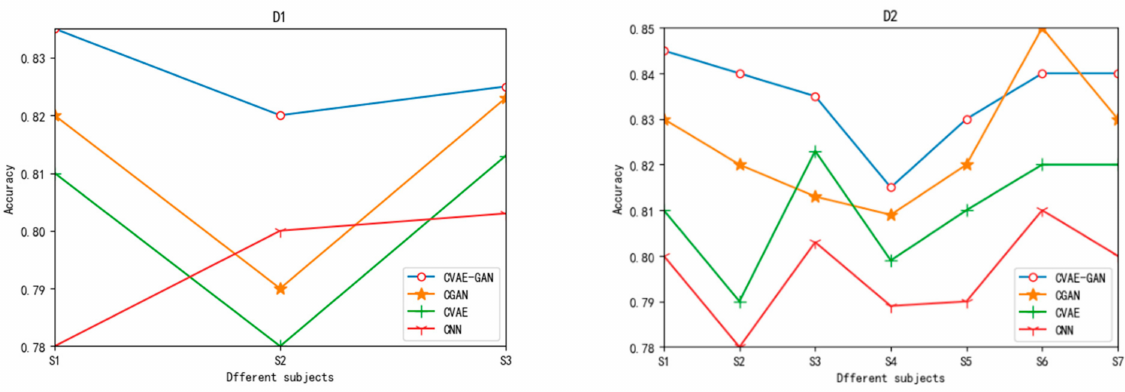
Figure 7. Experimental results of classification performance in the D1 and D2